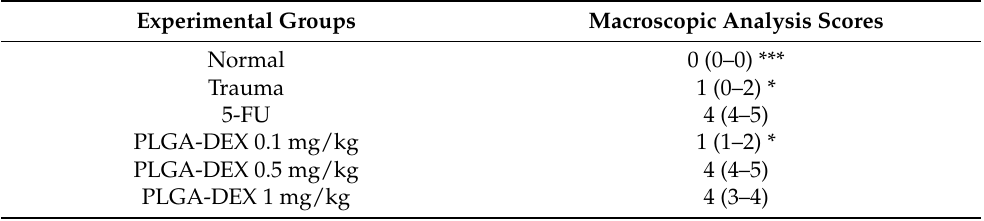
Table 3. Macroscopic scores from hamster oral mucosa with OM induced by 5-FU and MT. Scores are represented as medians ( n = 5). * p < 0.05; *** p < 0.001, vs. group 5-FU (Kruskal–Wallis test and Dunn’s multiple comparison